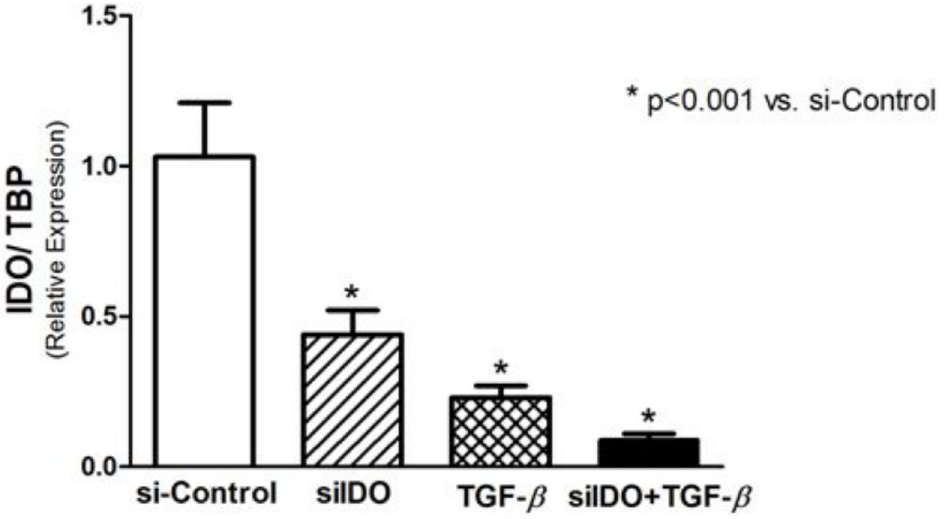
Fig 4. Real-time PCR for IDO to prove the effectiveness of the IDO-siRNA to induce IDO knockdown. A negative control-siRNA was used for si-Control and TGF- β conditions. A significant reduction of IDO expression was observed in siIDO cells, and in TGF- β -stimulated cells. The association of siIDO and TGF- β induced a more pronounced reduction of the IDO